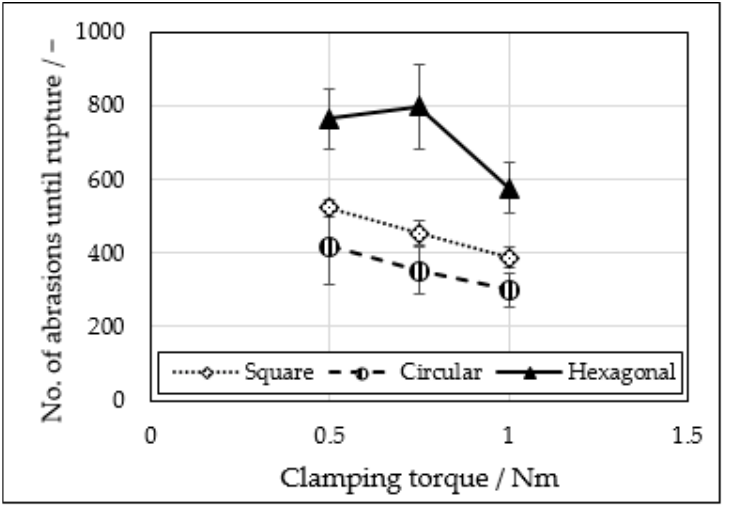
Figure 8. Number of abrasions until rupture of the thin nylon cloth for 0.5, 0.75, and 1.0 Nm for a square, a circular and a hexagonal edge geometry.